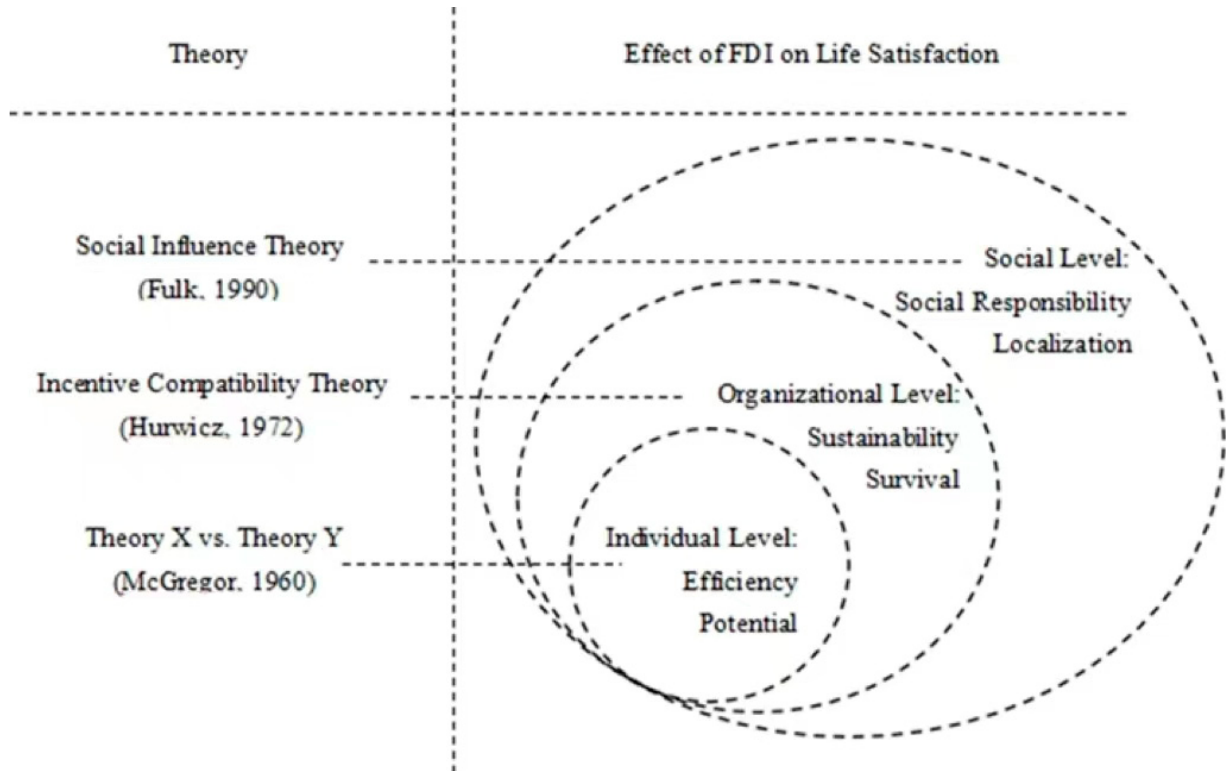
Figure 2. Theoretical explanation of the effect of FDI on wellbeing at different levels